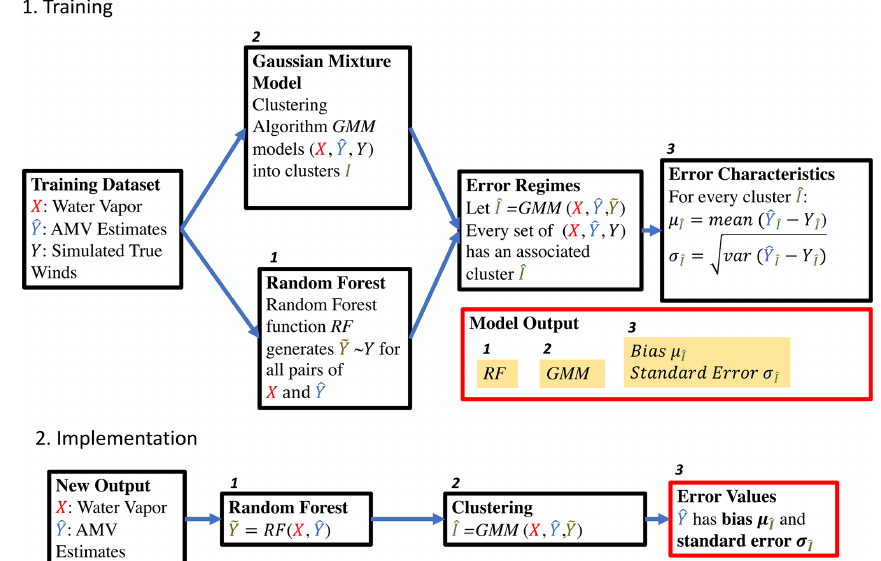
Figure 2. Diagram of training approach and diagram of implementation steps.